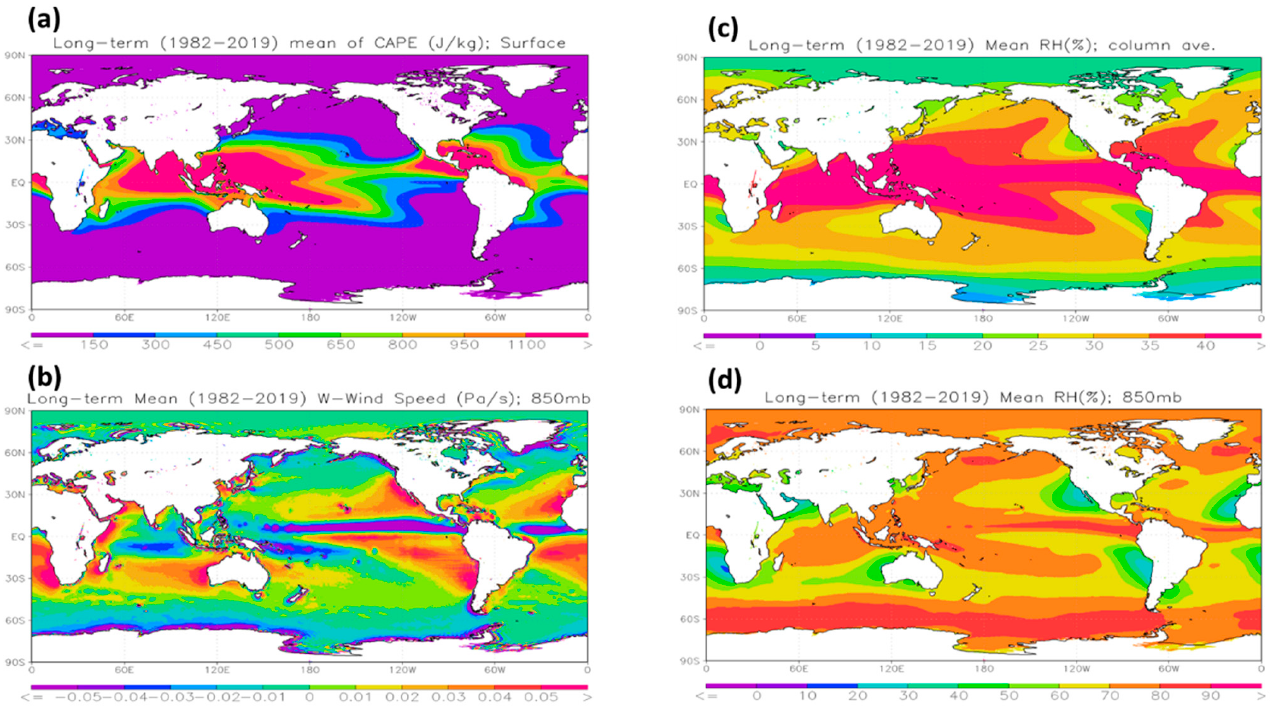
Figure 4. Distribution of long-term averaged monthly mean of ( a ) CAPE, ( b ) ω 850 , ( c ) RH clm , and ( d ) RH 850 over the global oceans.